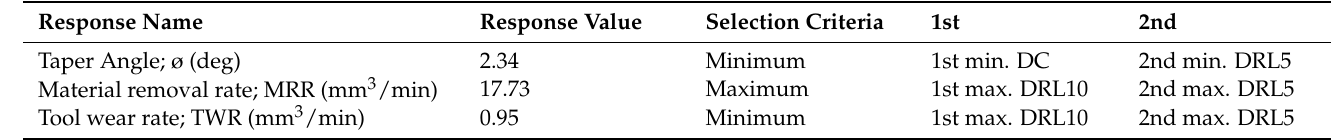
Table 5. Summary table to select the competitive